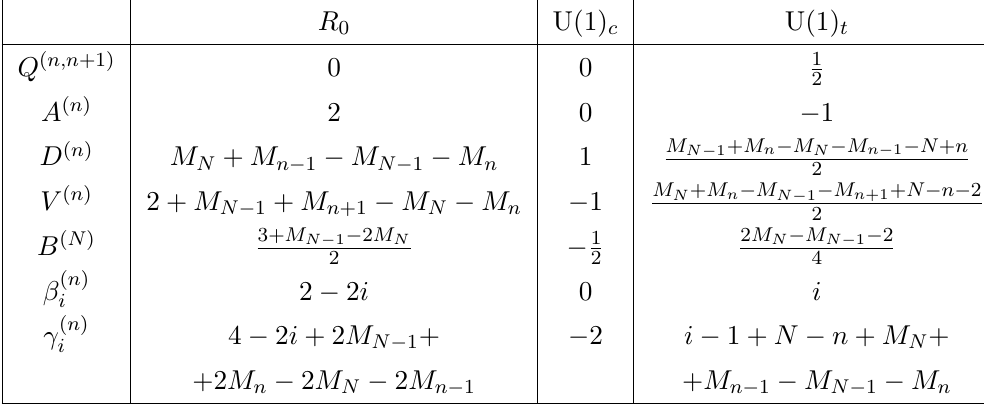
Table 3 . Charges under the abelian symmetries of the matter fields of the quiver gauge